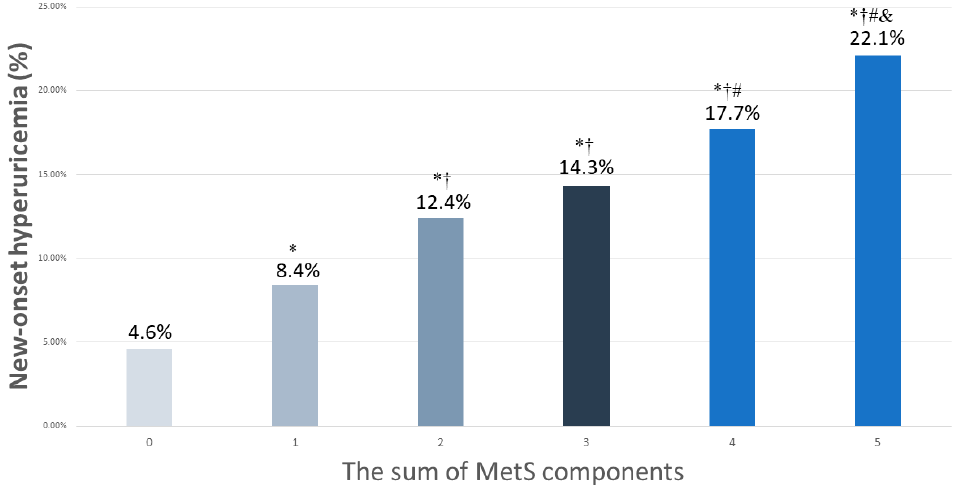
Figure 2. The percentage of new-onset hyperuricemia among 6 study groups, according to the sum